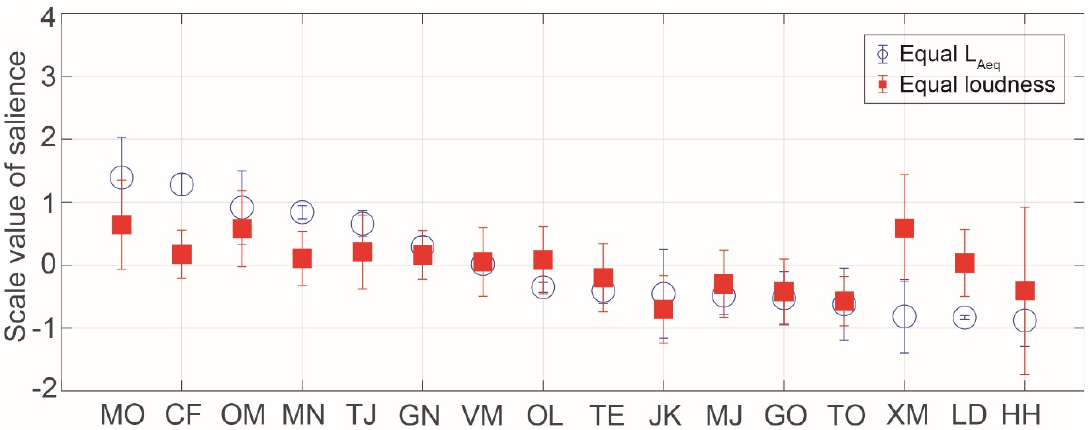
Figure 6. Scale values of saliences for insect songs in the equal L Aeq and loudness conditions. The symbols indicate the mean values and the error bars indicate standard deviations.